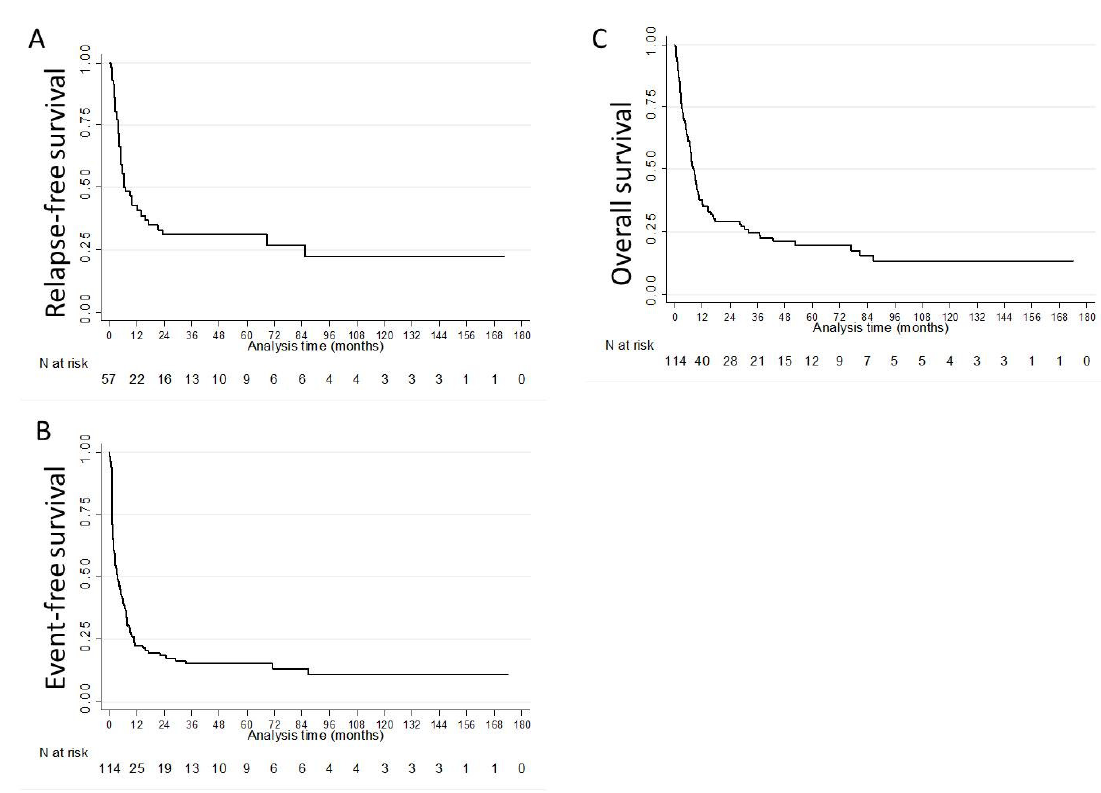
Figure 2. Outcome of patients with refractory or relapsed FLT3 -mutated acute myeloid leukemia: ( A ) relapse-free survival; ( B ) event-free survival; ( C ) overall survival.